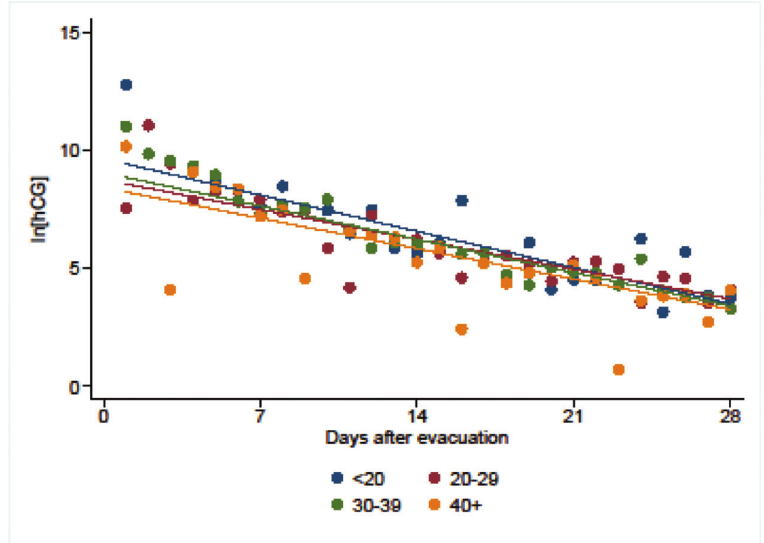
Figure S1 - Human chorionic gonadotropin (hCG) regression curves by age for all molar pregnancies. Each point represents the mean hCG level. No significant difference was noted in the rate of hCG regression by age for all ( p =0.13), complete ( p =0.18), or partial ( p =0.83) molar